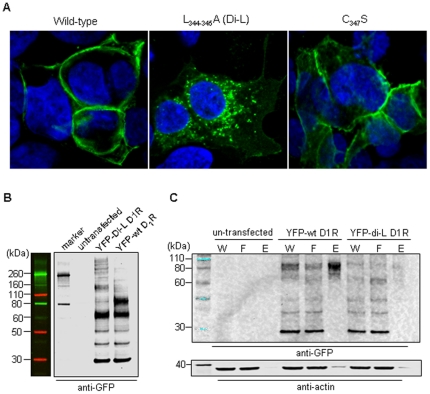
Trafficking of D1R C-terminal mutants.(A) HEK 293 cells transfected with YFP-tagged D1R plasmids grown on coverslips, and were fixed ∼36 hours post-transfection and subjected to confocal microscopy. Di-L and C347S were chosen as the representatives of the mutants. (B) HEK 293 cells were transfected with YFP-wt D1R and YFP-di-L D1R plasmids in 6-well plates. 36 hours after transfection, cells were washed twice with ice-cold PBS and then lysed in cold RIPA buffer containing 1 mM DTT and protease and phosphatase inhibitors on ice for 10 min. The cell lysates were subjected to SDS-polyacryalmide gel electrophoresis (4–12% gradient gel) and immunoblotted with goat-anti GFP antibody. (C) HEK 293 cells were cultured in 10-cm dishes and then transfected with same amount of YFP-wt D1R and YFP-di-L D1R plasmids. Cell surface biotinylation and isolation were performed using the commercial kit ∼24 h post-transfection. Non-transfected cells were included as a negative control. Samples were then immunoblotted with anti-GFP and anti-actin antibodies. W stands for whole cell lysate. F stands for flow through. E stands for elution.